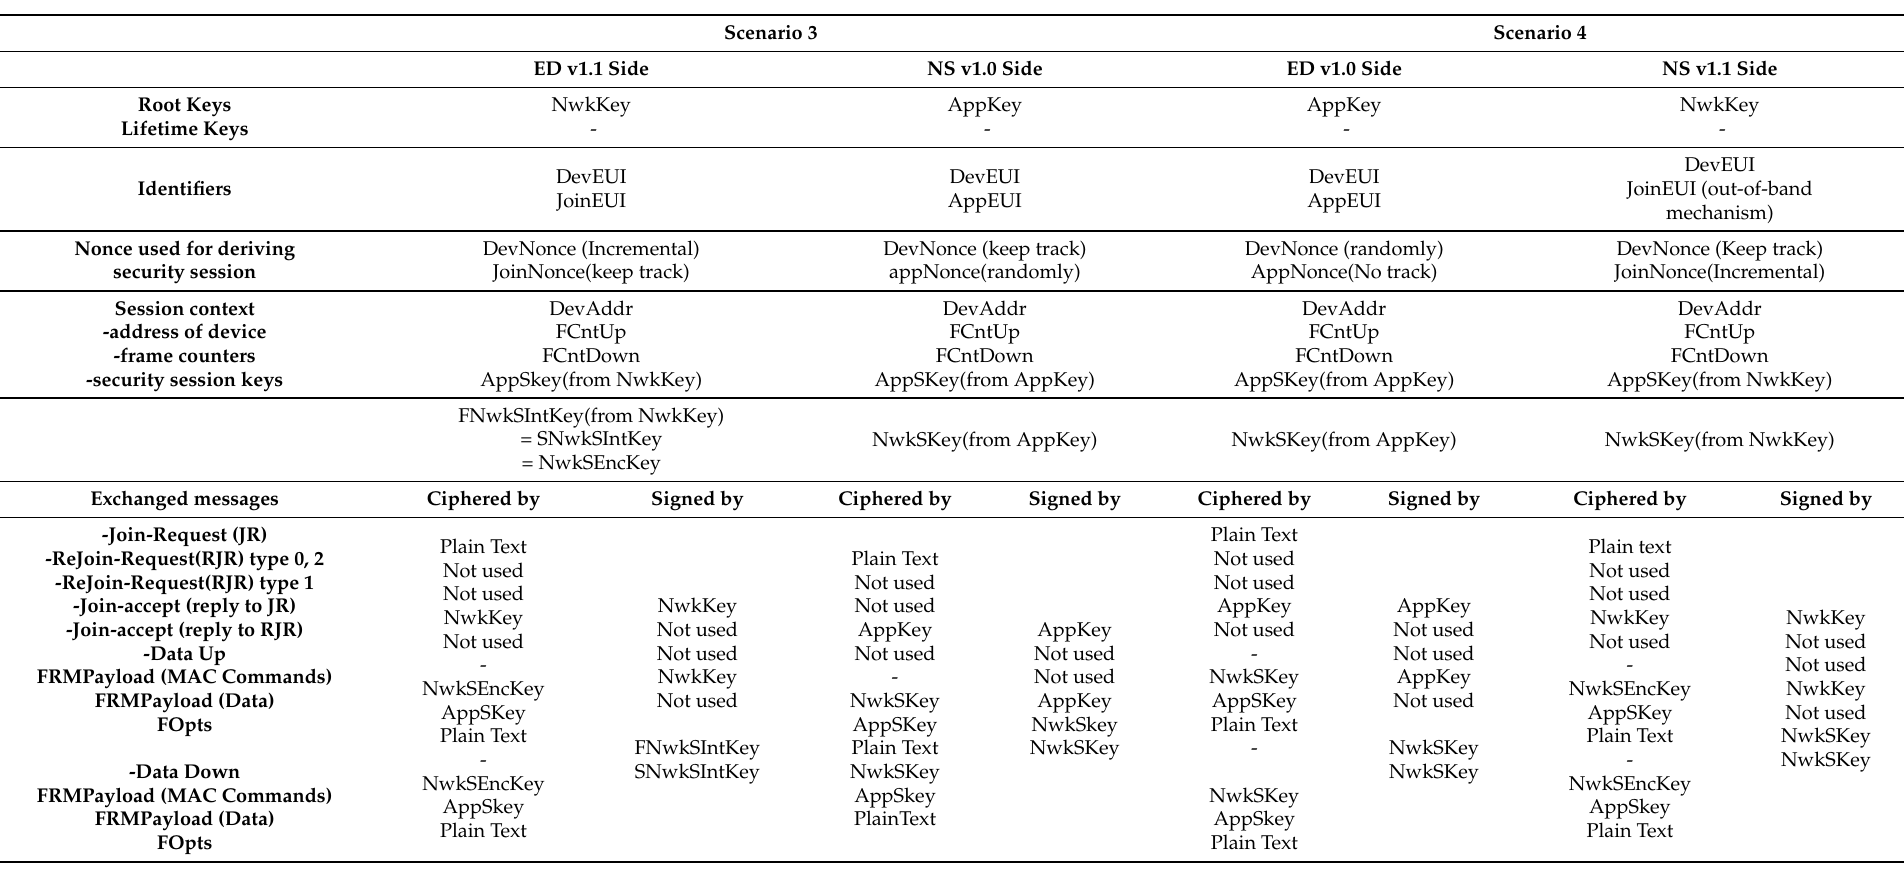
Table 3. A comparison between between scenarios 3 and